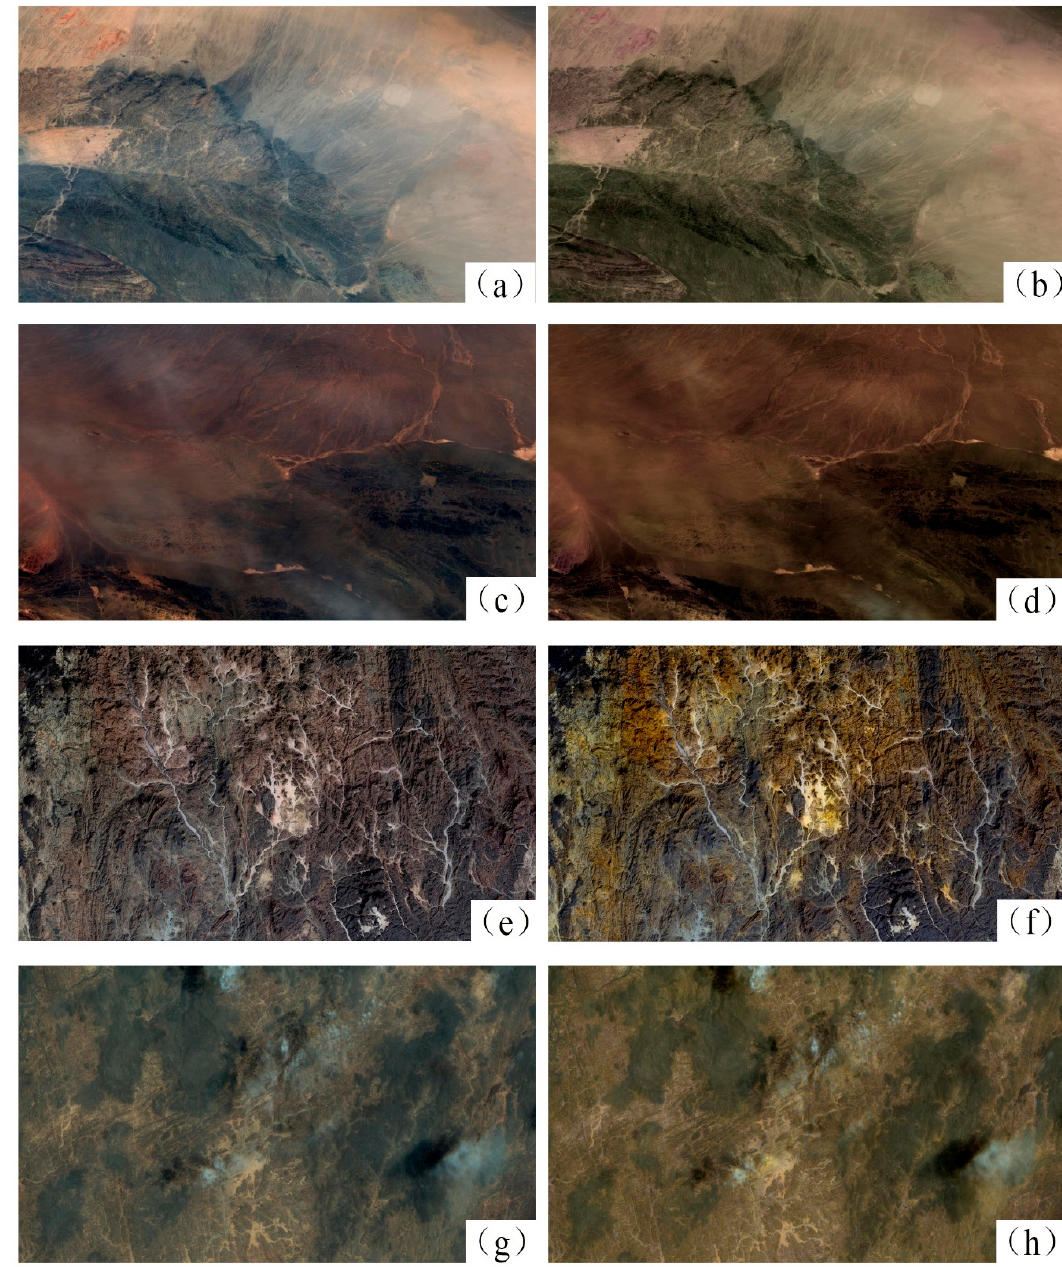
Figure 4. The atmospheric correction examples for the 4 different categories of MHSR imagery at 2 different AERONET sites. The four examples from top to bottom respectively are ( a , b ) GF-1/WFV3 at Dalanzadgad, ( c , d ) GF-1/WFV4 at Dalanzadgad, ( e , f ) Landsat8/OLI at Tamanrasset_INM, and ( g , h ) Sentinel2B/MSI at Tamanrasset_INM. Each of the 4 examples include two panels. The left column is the true color composite before atmospheric correction and the right column is the true color composite after the atmospheric correction.